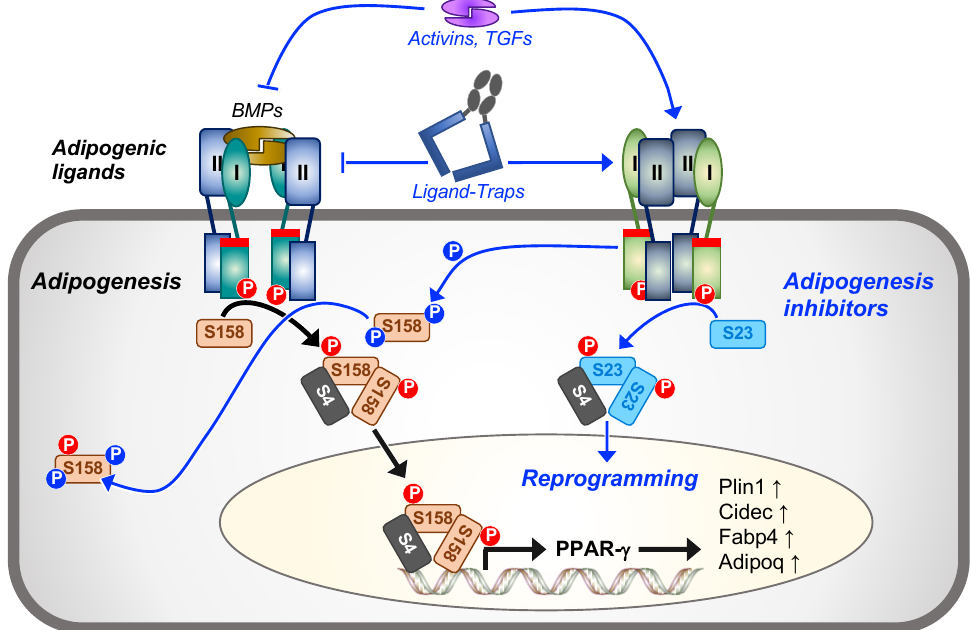
Figure 8. SMAD signaling and regulation in adipogenesis. Black arrows represent the proposed pathway of BMP/TGF- β signaling that leads to adipogenesis. BMPs and the type I receptor kinases, including ALK2, and ALK3 (Figures S1 and S8) activate SMAD1/5/8 signaling (orange rectangles labeled S158) by C-terminal phosphorylation (red circled P). Activated SMAD1/5/8 form a trimeric complex with SMAD4 (grey rectangles labeled S4), which translocates to the nucleus to directly or indirectly regulate expression of adipogenic genes, including Pparg, Plin1, Cidec, Fabp4 and Adipoq. SMAD2/3 signaling (light blue rectangles labeled S23) is inactive in adipogenesis. Blue arrows represent the proposed pathway of BMP/TGF- β signaling in adipogenesis arrest. Differentiating 3T3-L1 cells treated with anti-adipogenic traps and ligands show both SMAD2/3 activation and SMAD1/5/8 inhibition. SMAD2/3 activating kinases or SMAD2/3 regulated genes could negatively regulate SMAD1/5/8 signaling by inducing its hyperphosphorylation (blue circled P), which may lead to reduced SMAD1/5/8 nuclear translocation and transcriptional